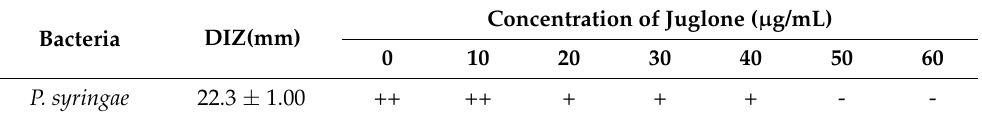
Table 1. Diameter of zone inhibition, minimum inhibitory concentration ( MIC ), and minimum bactericidal concentration ( MBC ) of juglong against P. syringae.